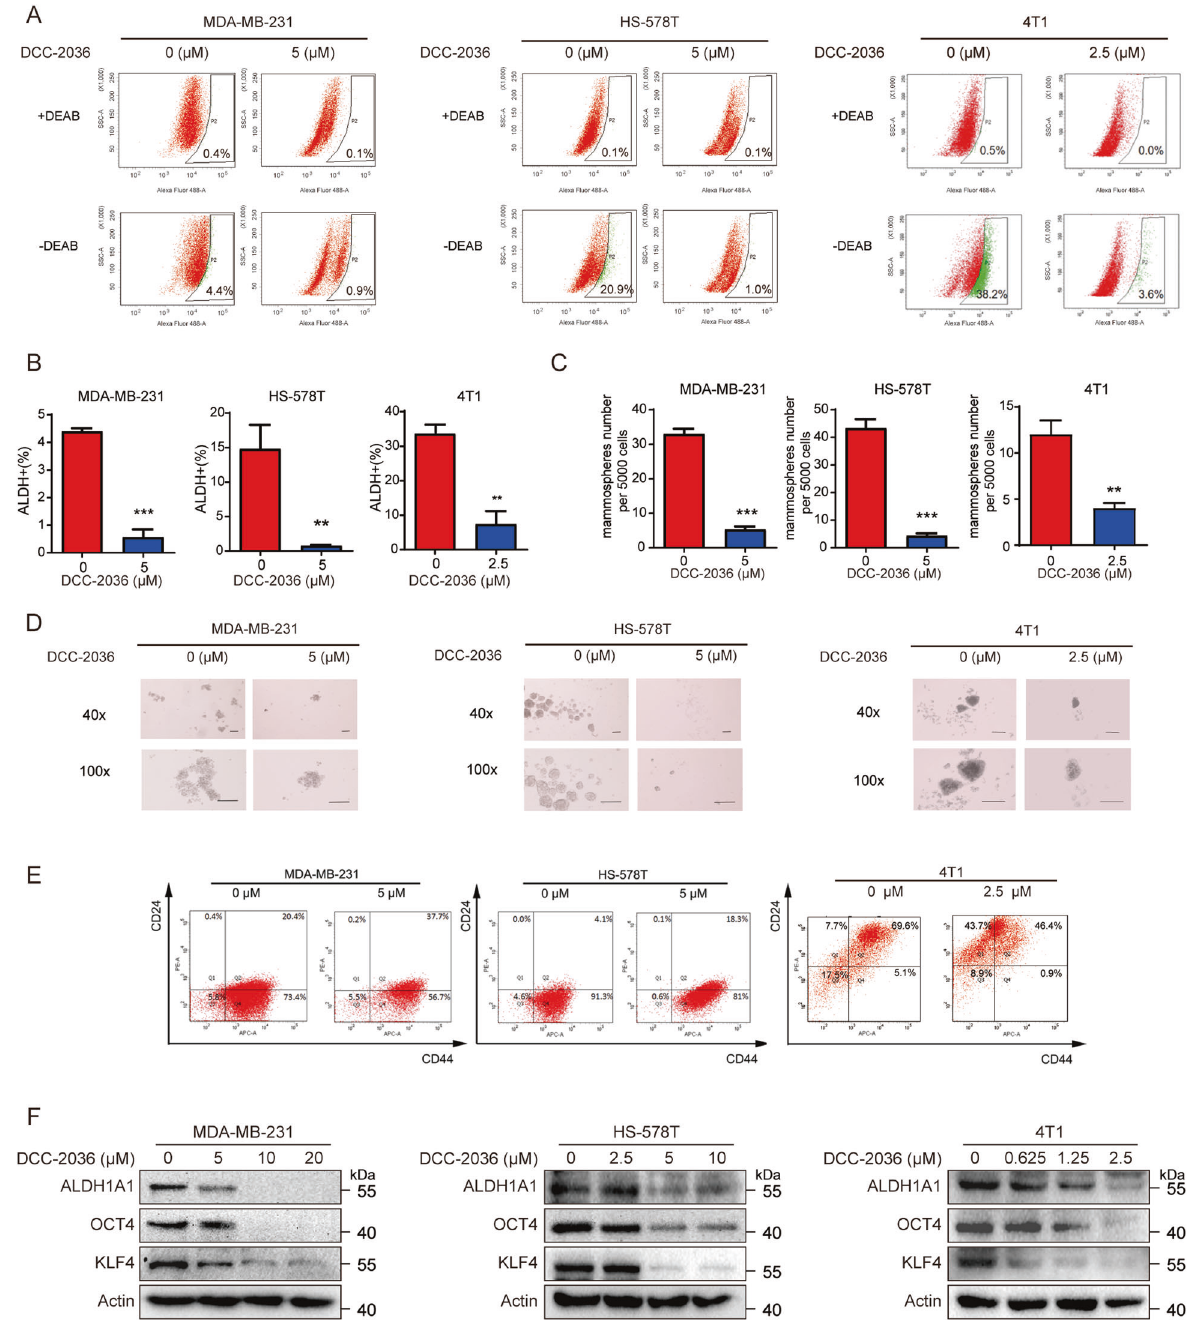
Fig. 1 Inhibitory effect of DCC-2036 on TNBC stem cells. A According to the ALDEFLUOR assay, DCC-2036 suppressed cancer stem cells (CSCs) obviously in the TNBC cell lines MDA-MB-231, HS-578T, and 4T1. After DCC-2036 treatment for 48 h, cells were incubated with activated ALDEFLUOR substrate followed by fl ow cytometry to measure the percentage of ALDH + cells. DEAB treatment functions as a negative control for ALDH + gating. Incubation of cells with ALDEFLUOR substrate in the absence of DEAB induces a change in fl uorescence that de fi nes the ALDH + population. DCC-2036 (0 μ M) means DMSO treatment with equivalent volume. B Former results are shown in bar charts ( n = 3, independent experiments). The statistical signi fi cance was determined by Student ’ s t -test. ** P < 0.01, *** P < 0.001. C , D The suppressive effect of DCC-2036 on TNBC stem cells according to the mammosphere formation assay. MDA-MB-231, HS-578T, and 4T1 cells were incubated with DCC-2036 for 48 h before they were plated onto 24-well ultra-low attachment plates (5000 cells each well). The number of mammospheres with diameters >60 μ m were counted after 7 days. D Representative images of mammospheres in a condition of treating with DCC-2036. Scale bars, 100 μ m. C The results are shown as bar charts ( n = 3, independent experiments). The statistical signi fi cance was determined by Student ’ s t -test. *** P < 0.001. E Flow cytometry analysis of the CD44 + CD24 − population in MDA-MB-231, HS-578T, and 4T1 cells after DCC-2036 treatment. F MDA-MB-231 cells, HS-578T cells, and 4T1 cells were treated with DCC-2036 with indicated concentration for 48 h. The protein levels of CSCs-associated markers were examined using Western